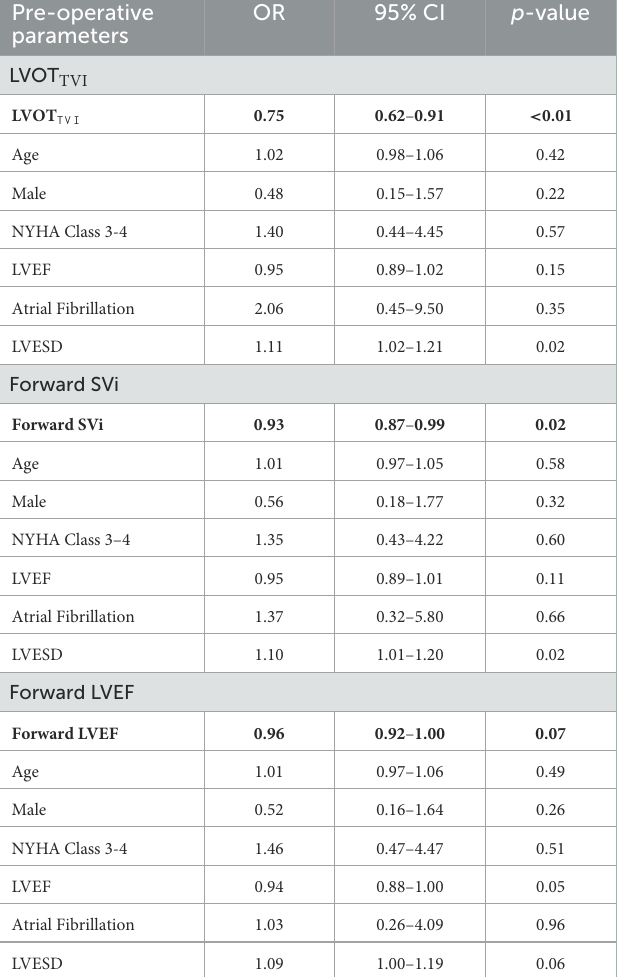
TABLE 4 Multivariable risk factor analysis for predicting post-operative LV systolic dysfunction in 198 patients undergoing mitral valve repair for severe DMR.